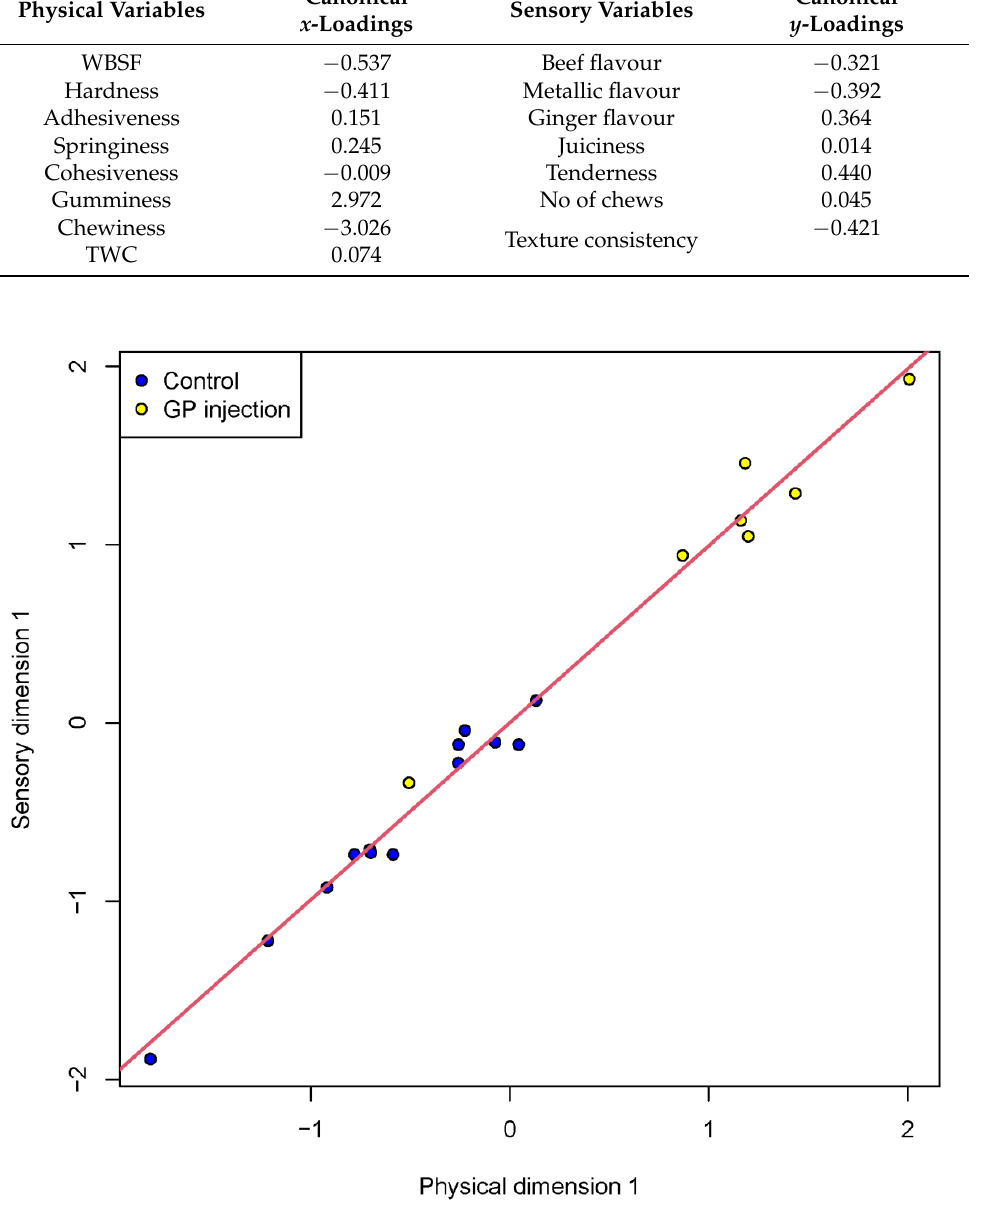
Figure 6. Canonical correlation plot showing first dimensions of physical (Warner-Bratzler shear force, hardness, adhesiveness, springiness, cohesiveness, gumminess, chewiness and total water content) and sensory traits (beef flavour/identity, metallic flavour, ginger flavour, tenderness, juiciness) of M. biceps femoris with injection treatment (control = without injection, GP injection = ginger powder injection containing zingibain) cooked at 65 ◦ C for 8 h and 12 h under sous vide conditions. Control and GP-injected samples are displayed in the plot. Blue dots = Control, yellow dots = GP-injected